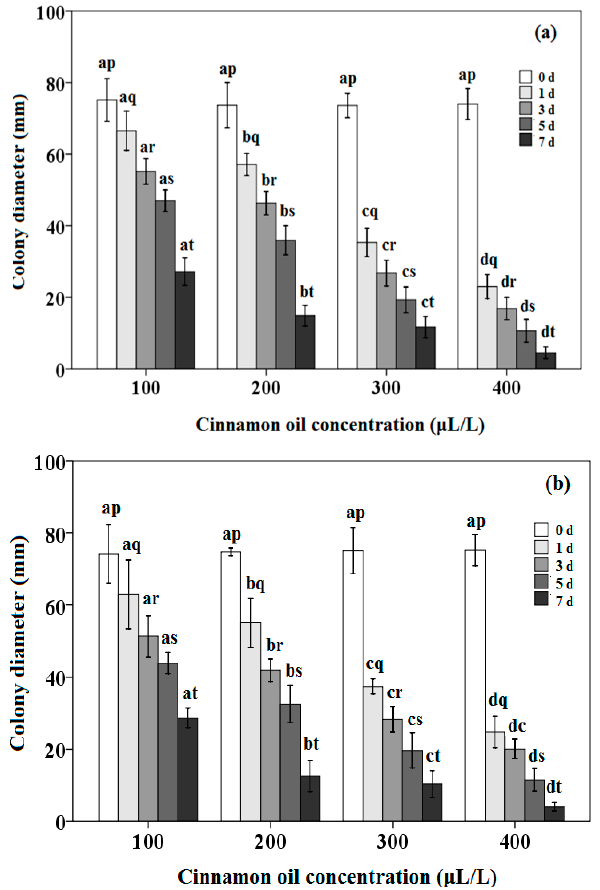
Figure 6. Antifungal activity of different attachment time of cinnamon oil with different concentrations against: P. citrinum ( a ); and A. flavus ( b ). Mean bars with different letters (a–d) indicate significant differences at p < 0.05 for the different concentration of cinnamon oil at the same attachment time. Mean bars with different letters (p–t) indicate significant differences at p < 0.05 for the different attachment time at the same concentration of cinnamon oil.